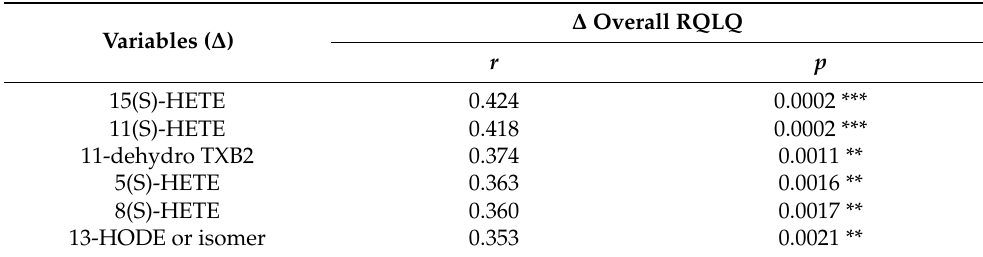
Table 3. Correlation between RQLQ improvement and change in metabolites’ concentration.